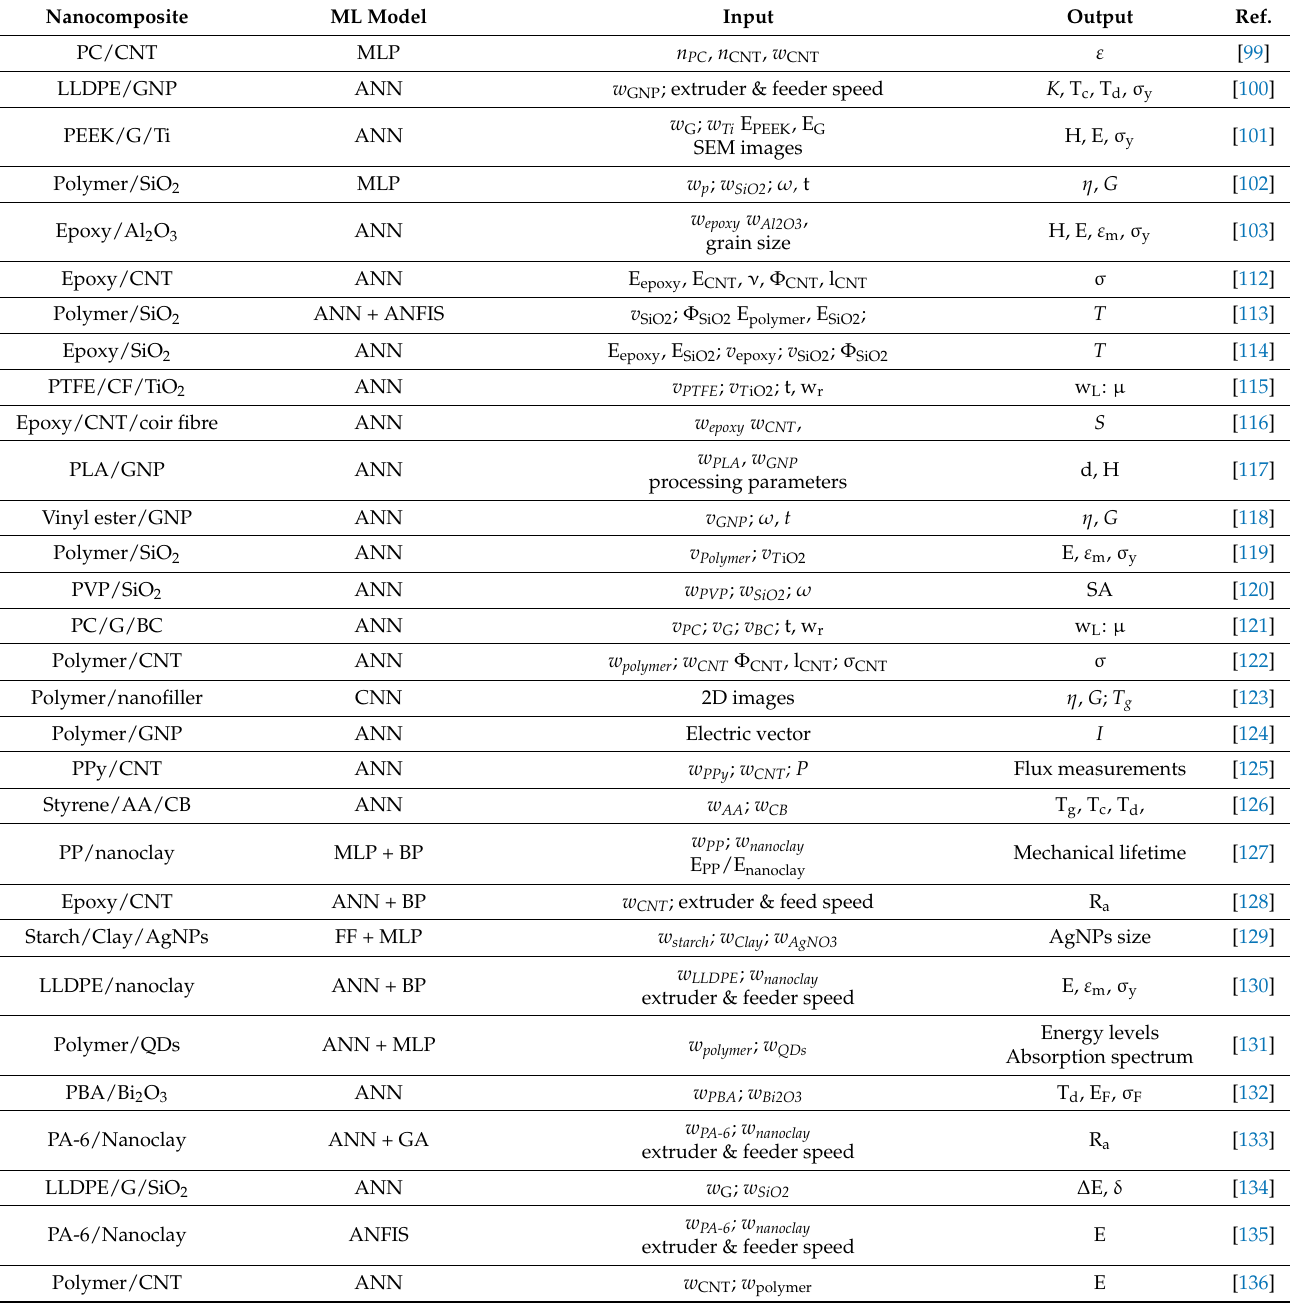
Table 1. Representative studies using artificial natural networks (ANNs) to predict the properties of polymeric